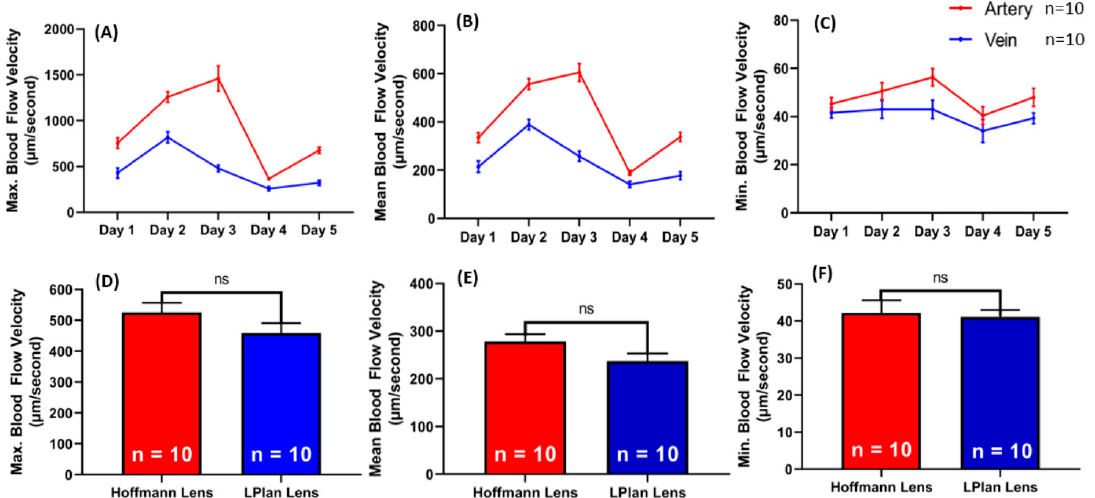
Figure 4. Comparison of blood flow velocity in zebrafish embryos. ( A – C ) Comparison of maximum, mean, and minimum blood flow velocity for the dorsal aorta (DA, red color) and posterior cardinal vein (PCV, blue color) in zebrafish embryos aged 1 to 5 dpf. ( D – F ) Comparison of the blood flow velocity in the DA using Hoffmann lens (red color) and non-Hoffmann lens (blue color).